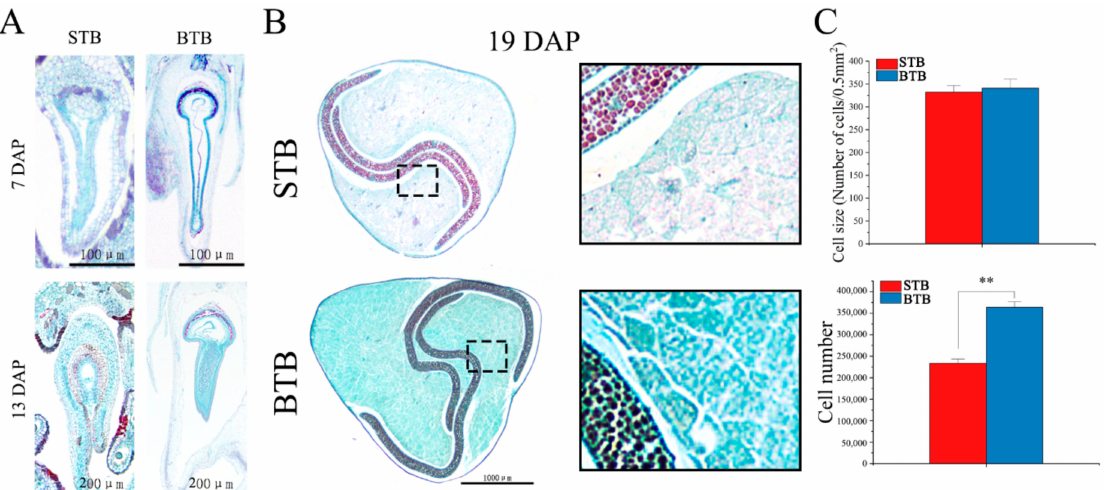
Figure 2. Embryo development of the different accessions. ( A ) Microscopic longitudinal sections of the different accessions of Tartary buckwheat fruits at 7 and 13 DAP. ( B ) Microscopic transverse sections of the different accessions of Tartary buckwheat fruits at 19 DAP ( right panel is the enlarged view of the boxes in the left panel ). ( C ) Cell size (0.5 mm 2 ) ( n = 5) and cell number ( n = 5) in mature fruits of the two accessions; ** indicates significant differences at the level of 0.01.